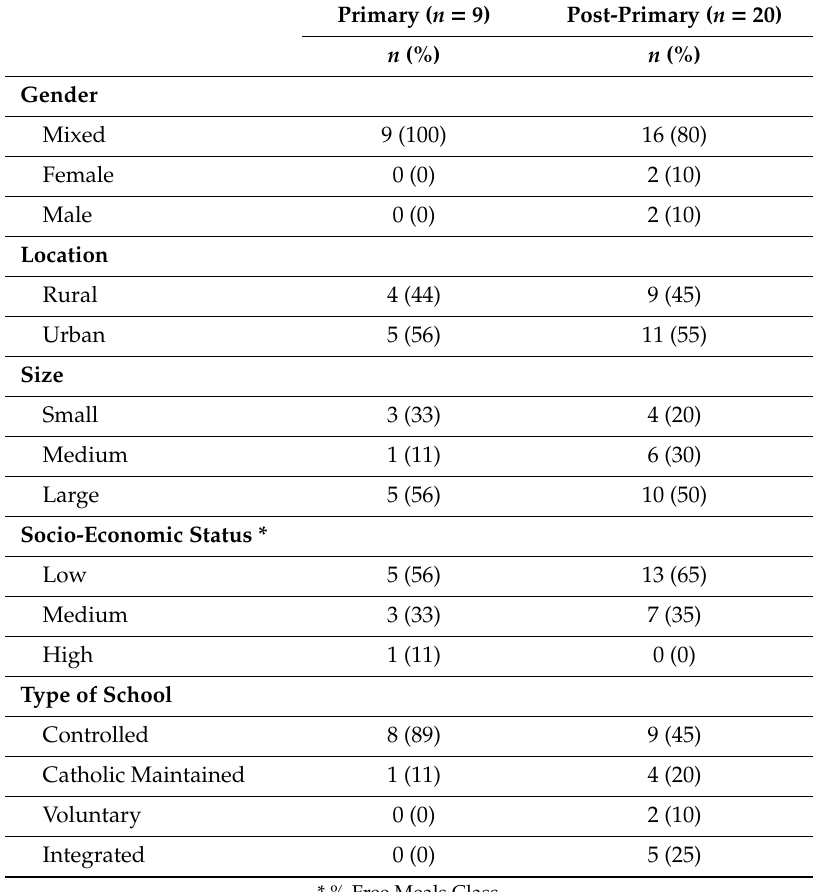
Table 1. Demographics of schools.